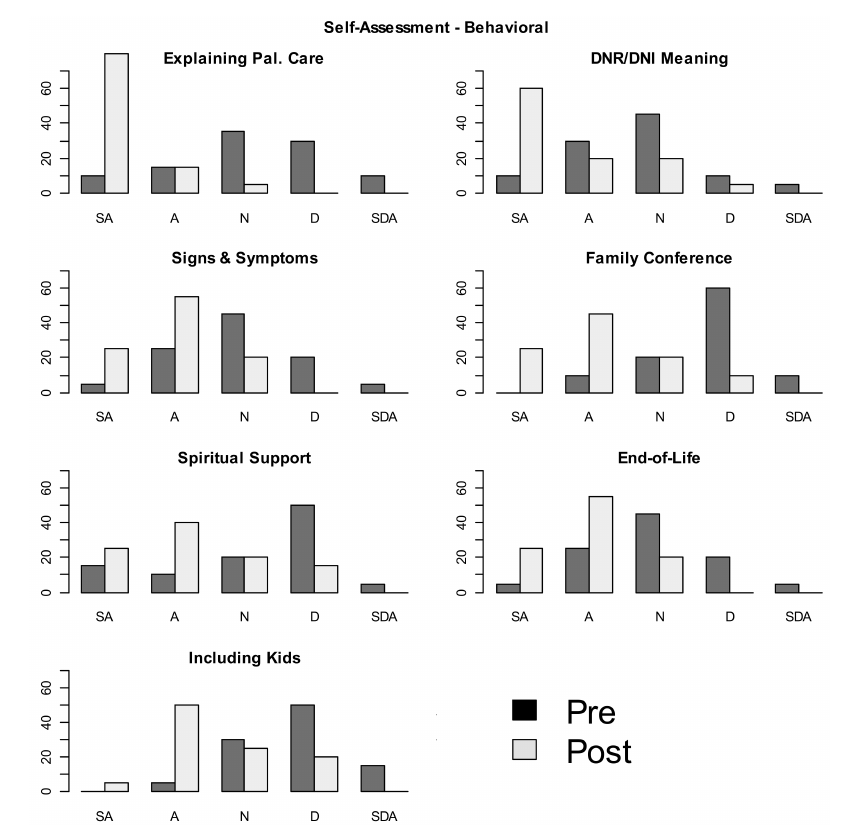
Figure 1. Pediatric resident personal comfort with palliative care competencies pre- and post-curriculum implementation. DNR = Do Not Resuscitate, DNI = Do Not Intubate. Note that the Y-Axis refers to percentage of